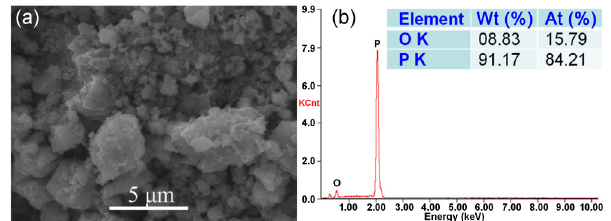
Fig. 2 (a) XRD pattern of RP material withdifferent ball-milling times; (b) Raman pattern of RP material with different ball-milling times.